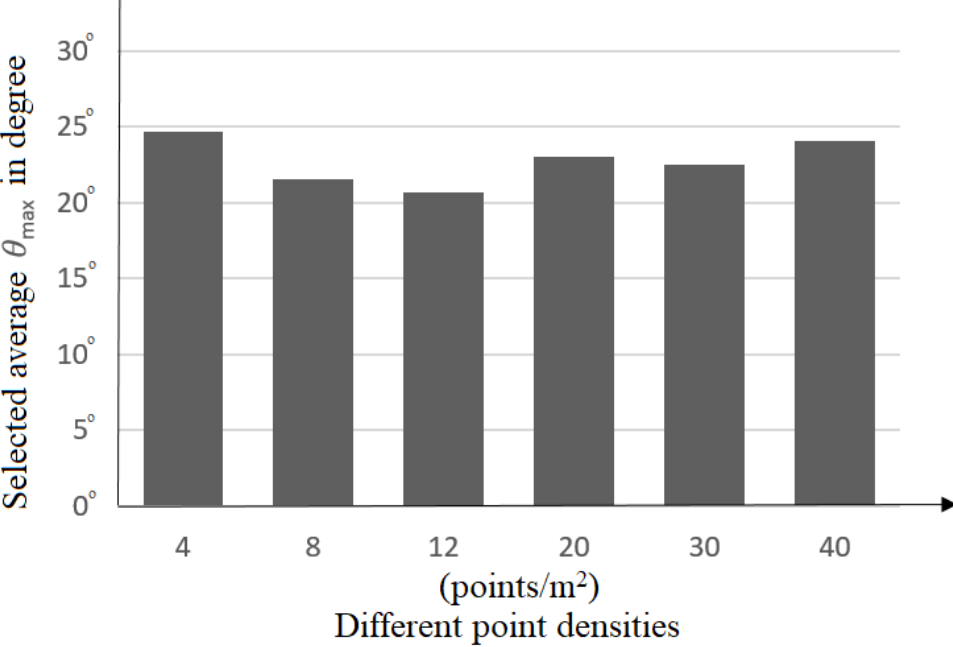
Figure 6. Average θ max values for the fold points under different point